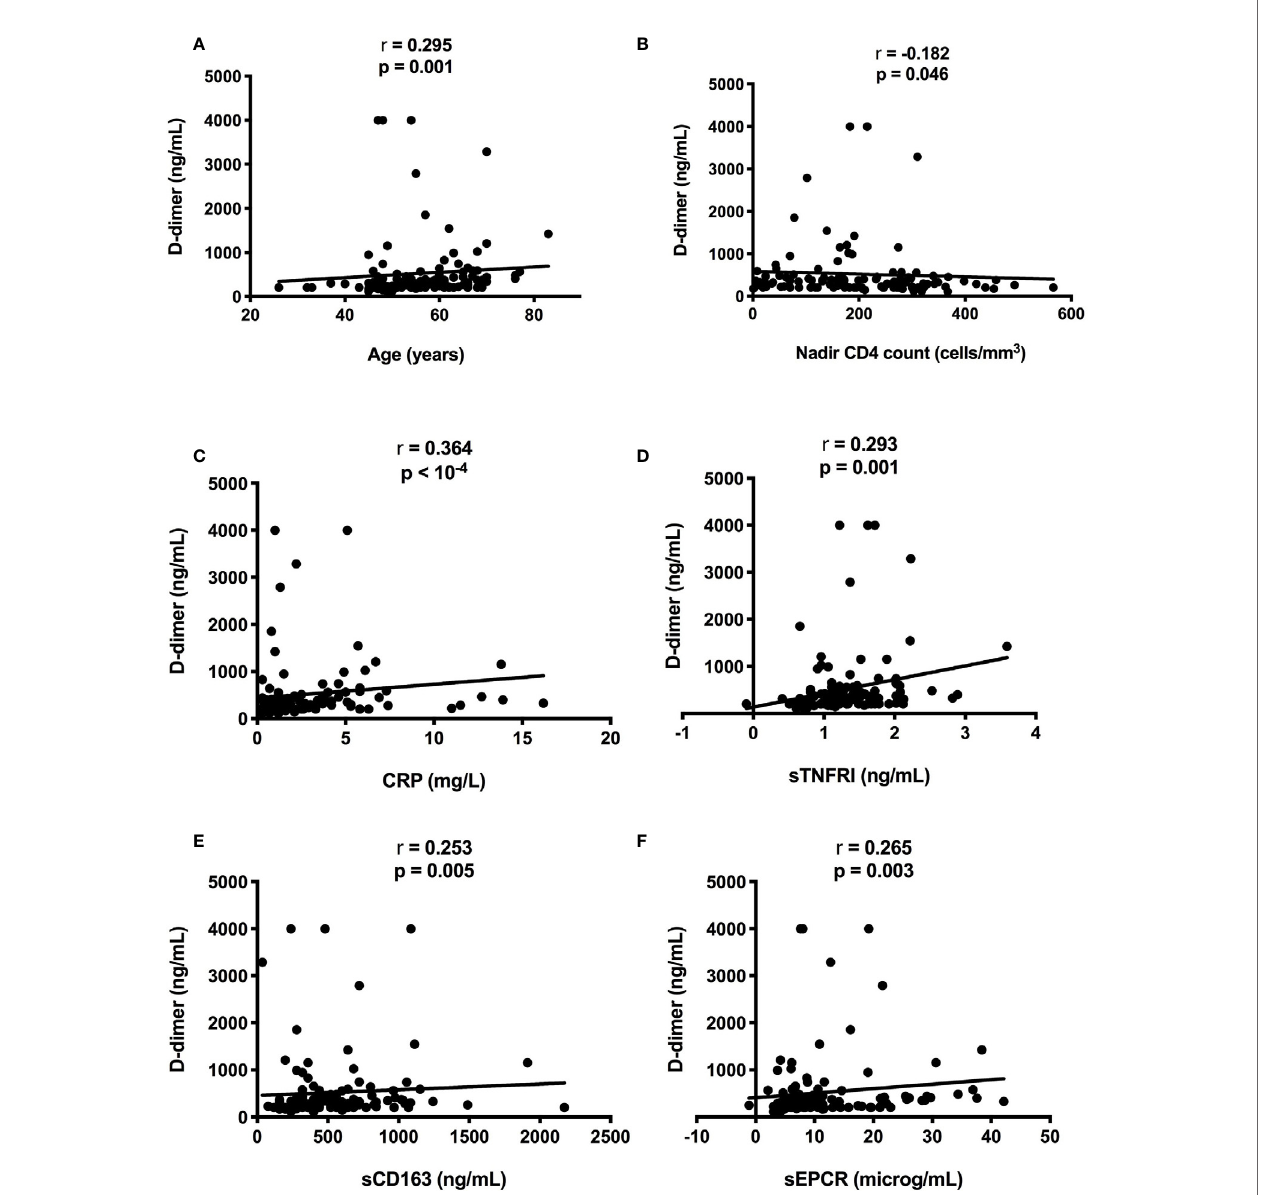
FIGURE 2 | Correlations between D-dimer level, participant age (A) and pretherapeutic CD4 count (B) , CRP (C) , sTNFRI (D) , sCD163 (E) , and sEPCR (F)